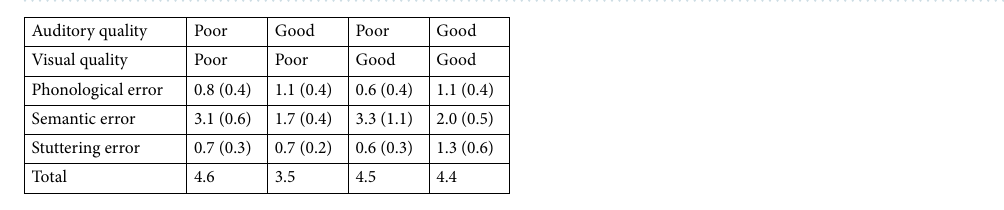
Auditory quality (good vs. poor), Visual quality (good vs. poor). The main effect for Motor speech production was significant bilaterally in the anterior insula, premotor, supplementary motor, primary motor, and primary somatosensory cortex, as well as in the right-hemisphere dorsolateral prefrontal cortex, right-hemisphere pos- terior STS, left-hemisphere pPT, and in the right-hemisphere temporo-parietal junction (Fig. 5A, red/yellow). These clusters were associated with significantly stronger activations during the motor tasks than the non-motor tasks. In contrast, the non-motor tasks activated bilaterally the fusiform gyrus and the orbitofrontal cortex more strongly than the motor tasks (Fig. 5A, blue/cyan). The main effect of Attention to AV speech was significant in the visual cortex (V1, V2) bilaterally, and in the left IFG and the STG where the shadowing and listening tasks a were associated with stronger activity than the